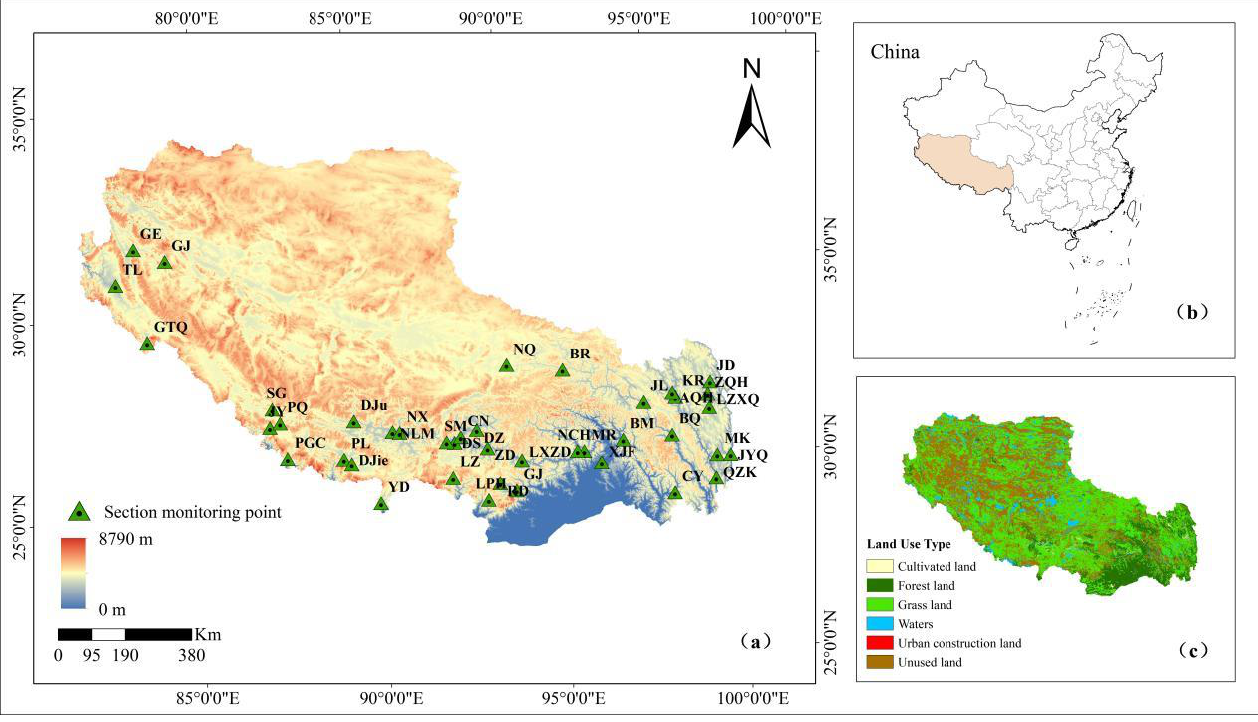
Table 1. Basic information of monitoring sections.